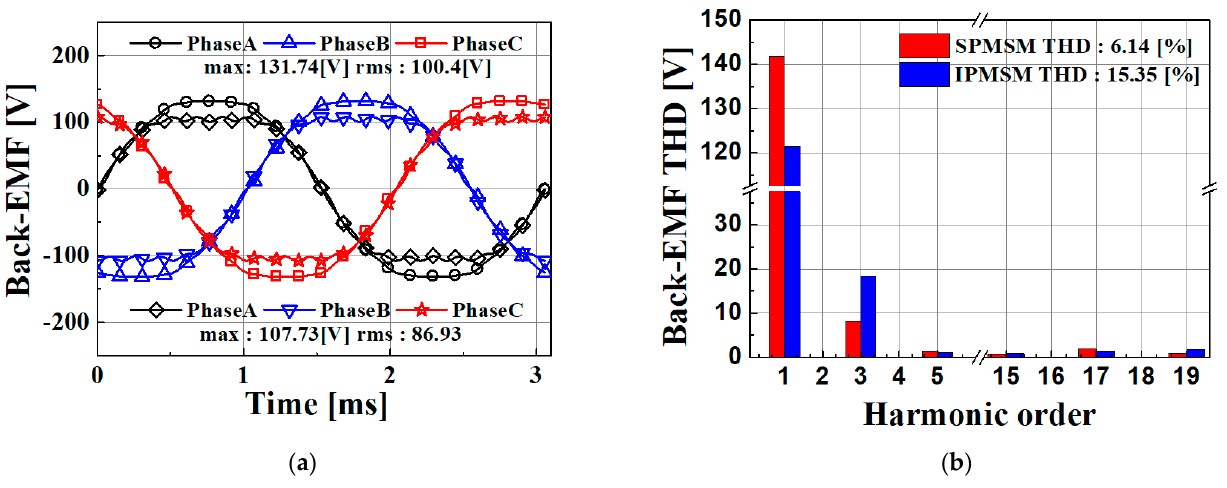
Figure 5. Characteristic analysis results: ( a ) back EMF, ( b ) back EMF FFT.